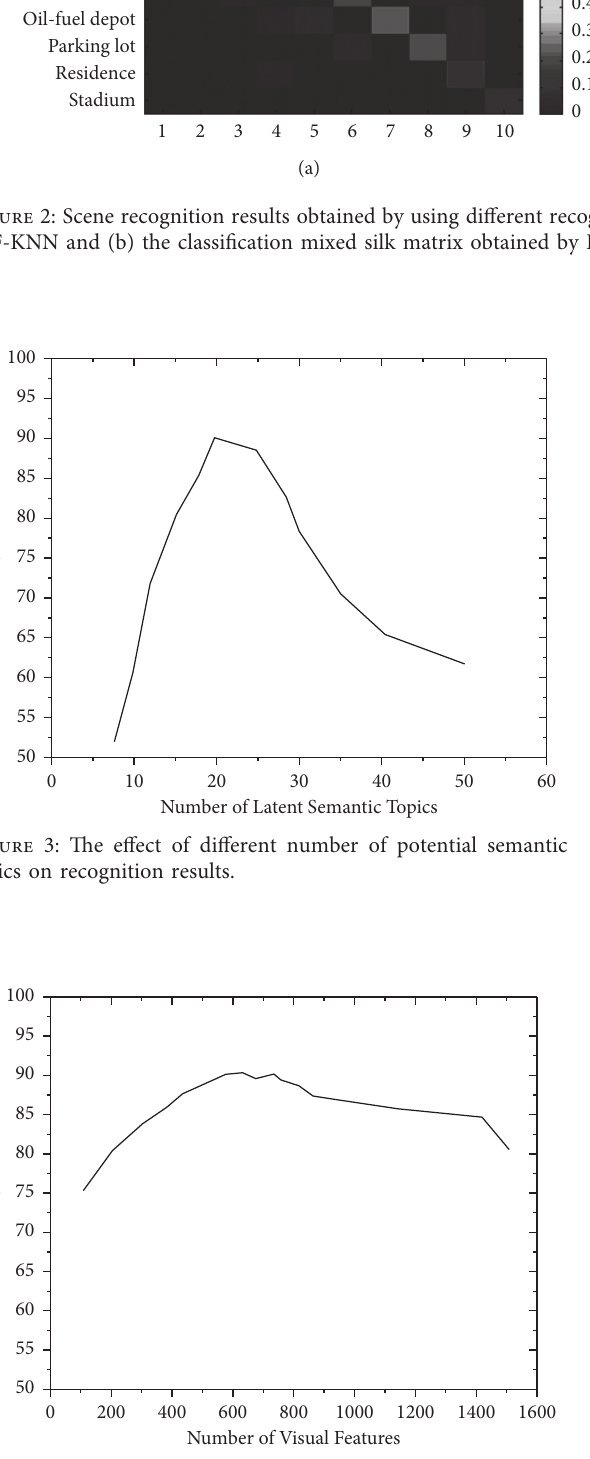
Figure 4: The influence of different visual terms on recognition